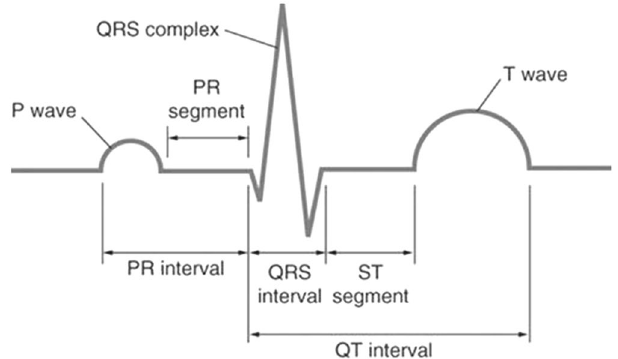
Figure 1. Standard ECG